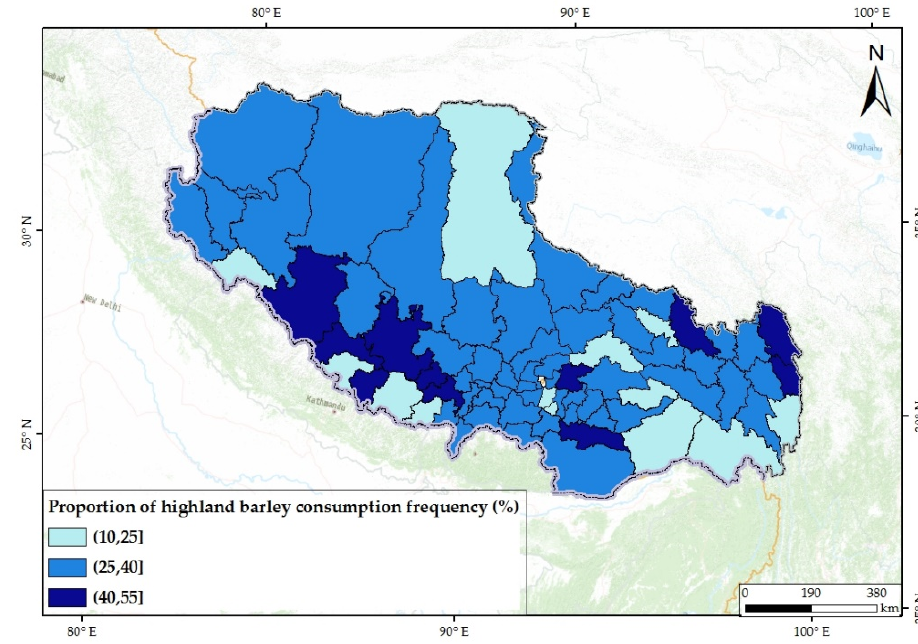
Figure 7. Mean values of the proportion of highland barley consumption frequency of counties.